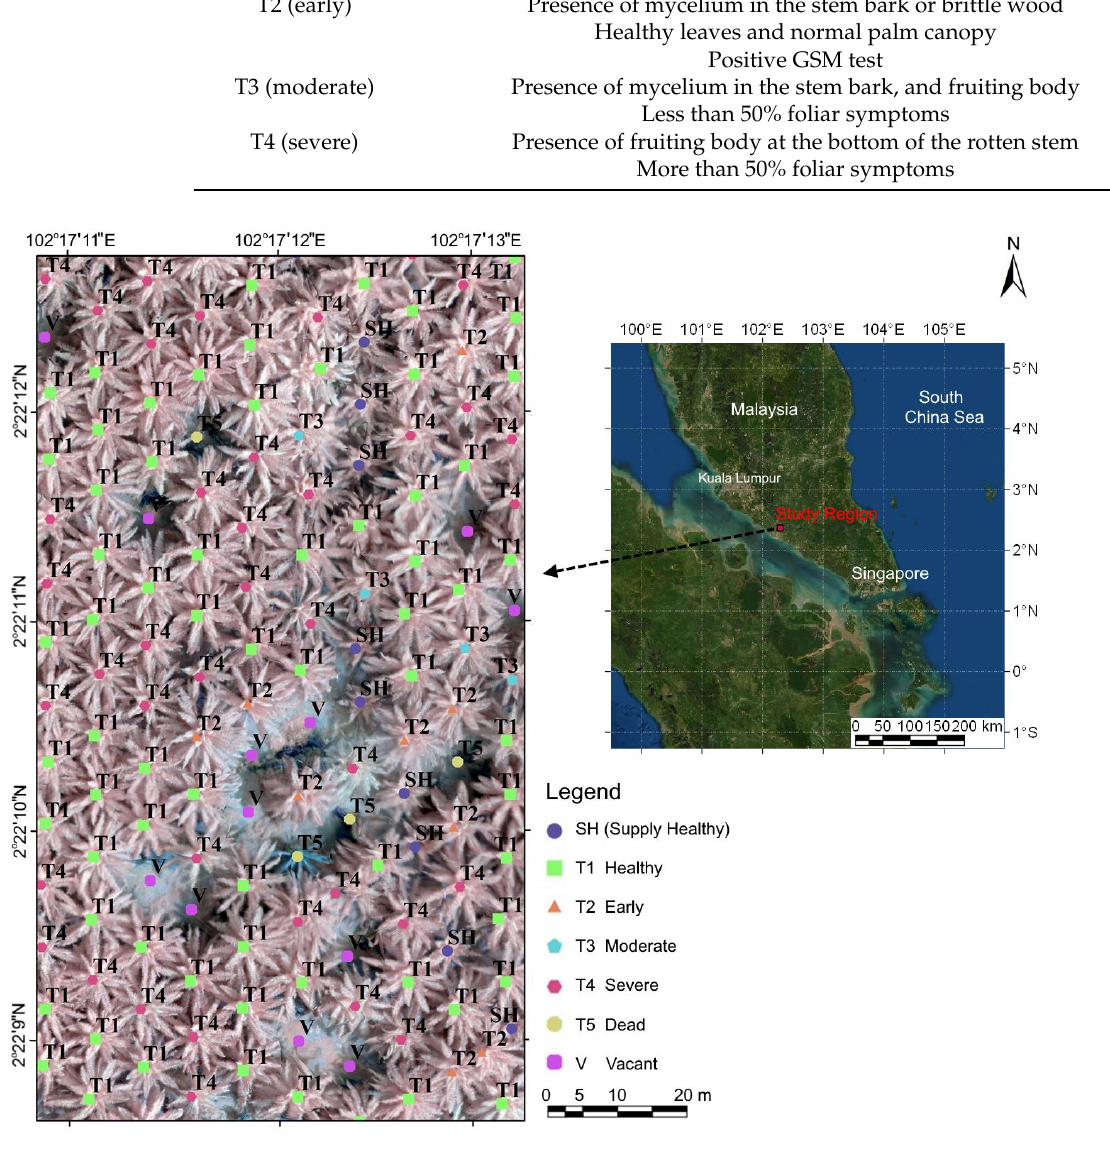
Figure 1. Study region. The ( right ) panel is a Google Satellite image, and the ( left ) panel shows a near-infrared image of the study region (pseudo R: NIR band; G: red band; B: green